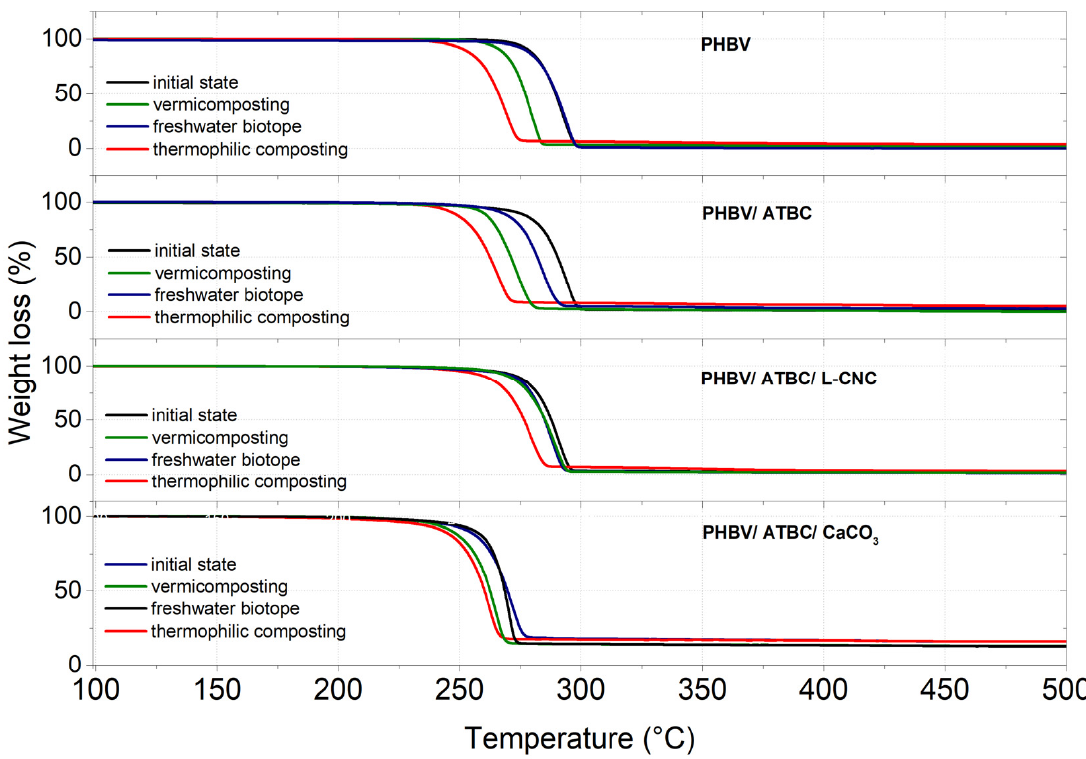
Figure 4. Thermogravimetric analysis (TGA) curves of PBHV bio-composites at initial state, and after 30 days of degradation. Table 5. Thermogravimetric analysis (TGA) data of PHBV bio-composites at initial state, and after 30 days of degradation.